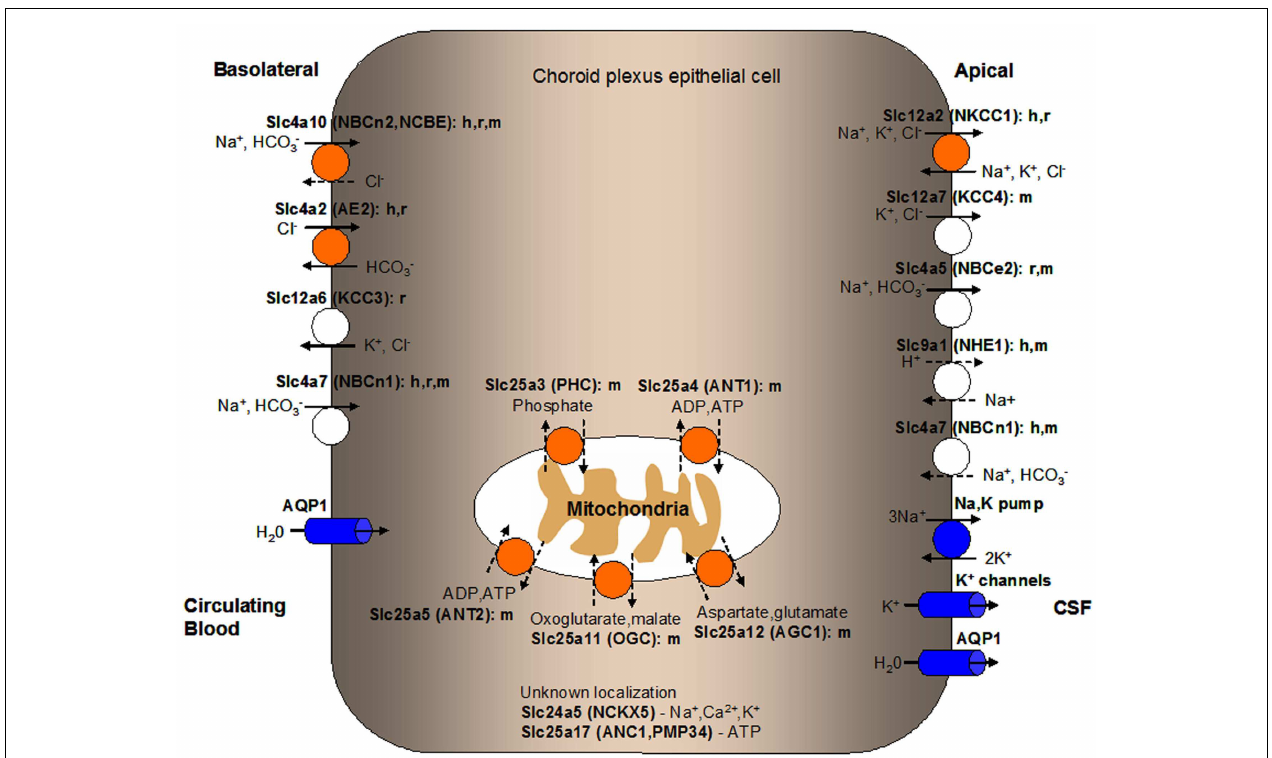
tissues from various mammalian species as indicated (h, human; r, rat; m, mouse). Ions or substrates being transported by each transporter or channel are shown. Relatively well-established directionality of transport is shown by solid arrows while dashed arrows indicate potential directionality of transport.Transporters with unknown CP localization are listed along with their main substrates. Predicted localization of mitochondrial carriers is shown along with potential physiological substrates. CSF, cerebrospinal